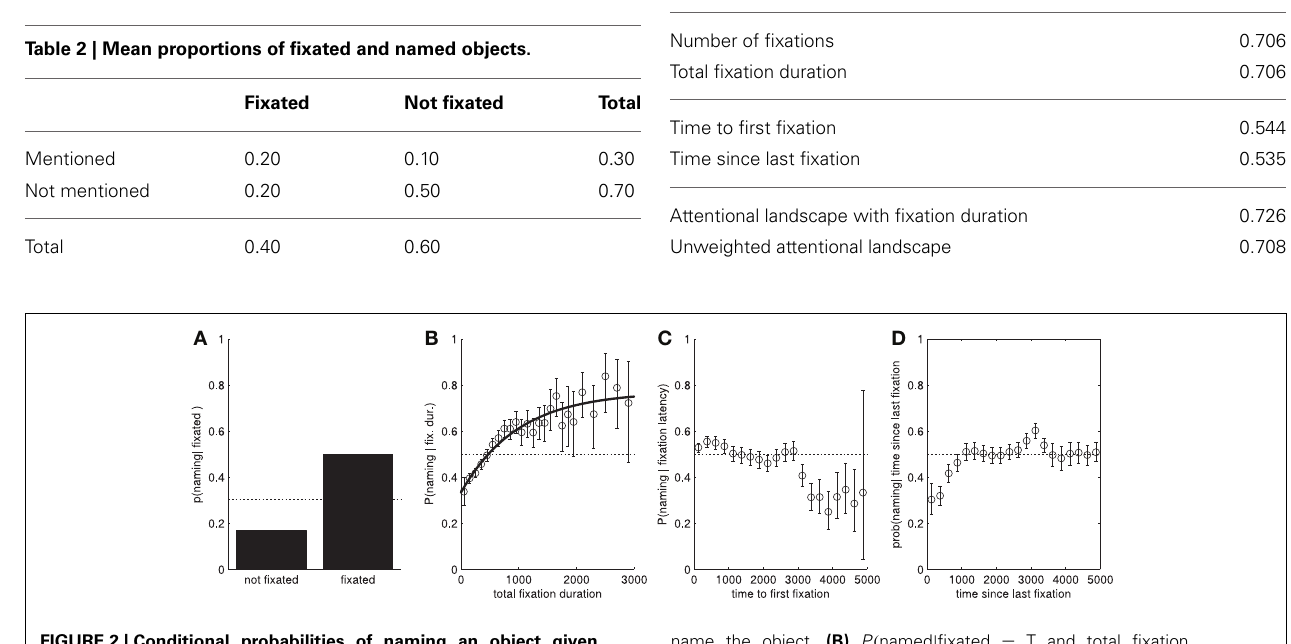
name the object. (B) P ( named | fixated = T and total fixation duration = x ) . (C) P ( named | fixated = T and time to first fixation = x ) . (D) P ( named | fixated = T and time since last fixation = 5000 − x ) . Note: we have transformed the x -axis so the trend can easily be compared with (C)